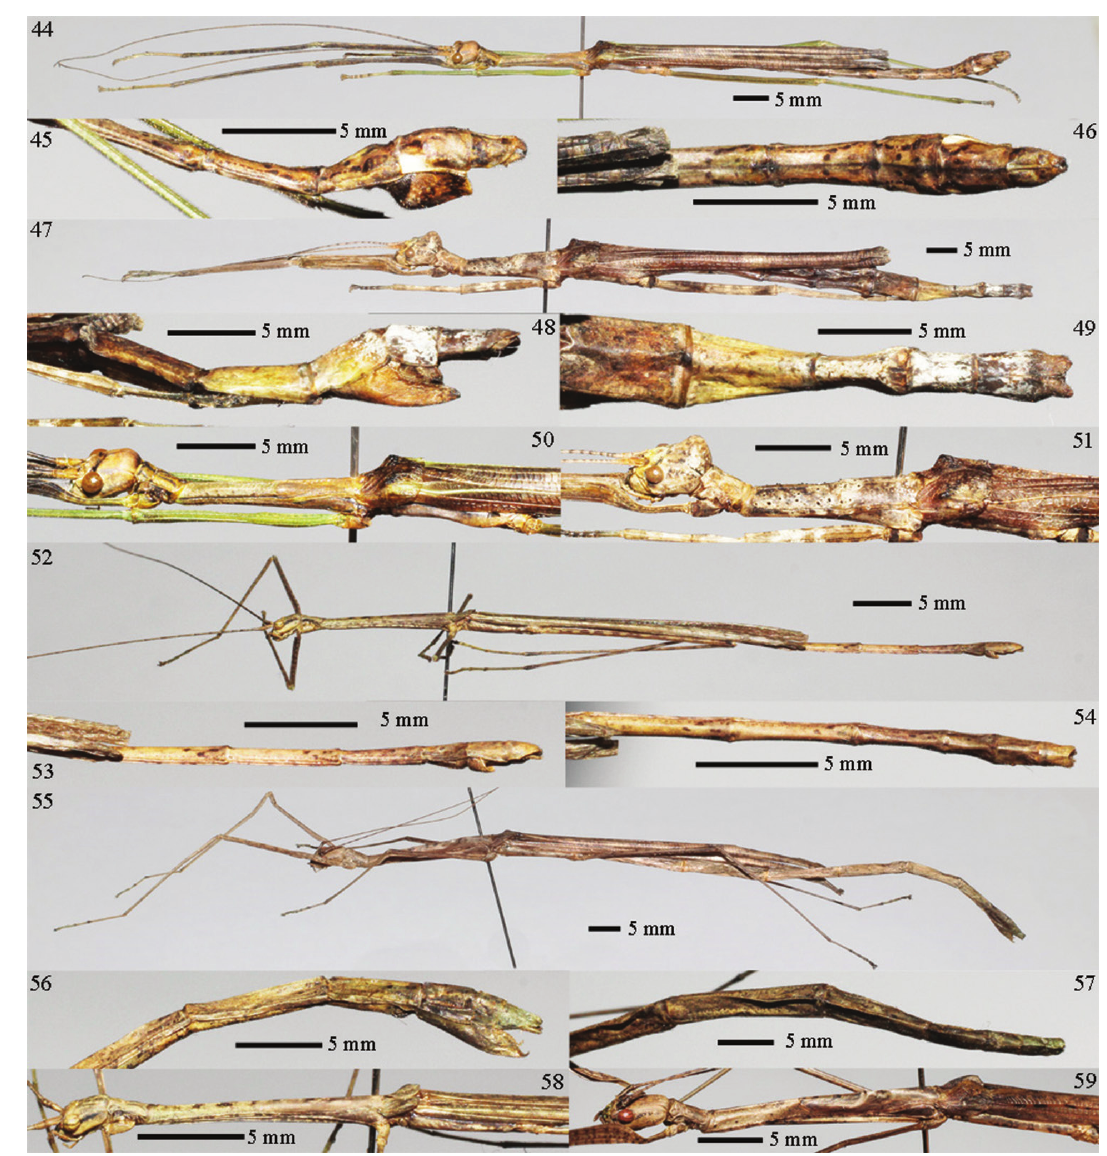
Figs 44–59. Parasinophasma spp. 44. P . laifanae sp. n.: ♂ , habitus; 45. P . laifanae sp. n.: ♂ , apex of abdomen, lateral view; 46. P . laifanae sp. n.: ♂ , apex of abdomen, dorsal view; 47. P . laifanae sp. n.: ♀ , habitus; 48. P . laifanae sp. n.: ♀ , apex of abdomen, lateral view; 49. P . laifanae sp. n.: ♀ , apex of abdomen, dorsal view; 50. P . laifanae sp. n.: ♂ , head and thorax, dorsolateral view; 51. P . laifanae sp. n.: ♀ , head and thorax, dorsolateral view; 52. P . liui sp. n.: ♂ , habitus; 53. P . liui sp. n.: ♂ , apex of abdomen, lateral view; 54. P . liui sp. n.: ♂ , apex of abdomen, dorsal view; 55. P . liui sp. n.: ♀ , habitus; 56. P . liui sp. n.: ♀ , apex of abdomen, lateral view; 57. P . liui sp. n.: ♀ , apex of abdomen, dorsal view; 58. P . liui sp. n.: ♂ , head and thorax, dorsolateral view; 59. P . liui sp. n.: ♀ , head and thorax, dorsolateral view. Coloration: General color of body yellowish brown. Legs yel- longer than ninth tergum. Anal segment almost as long as eighth lowish brown. Tegmina and alae yellowish brown with green pos- tergum, with a minute and indistinct emargination on posterior terior area. Alae yellowish brown with green posterior area, anal margin. Supra-anal plate indistinct. Subgenital plate scoop-shaped, region pale white with brown tapering posteriorly, apex pointed and reaching middle area of anal segment. Gonapophyses not exposed. Cerci long and straight, flat- tened, tapering posteriorly, apices pointed and surpassing posterior margin of anal segment. Legs sparsely covered with short bristles.